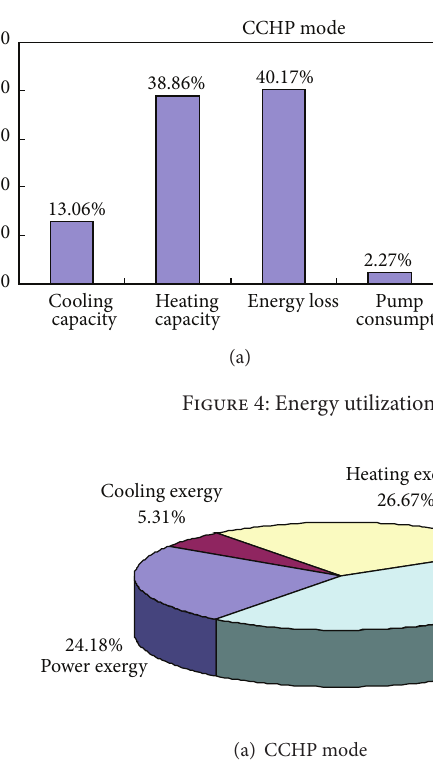
Figure 5: Exergy utilization profiles of operation modes A and